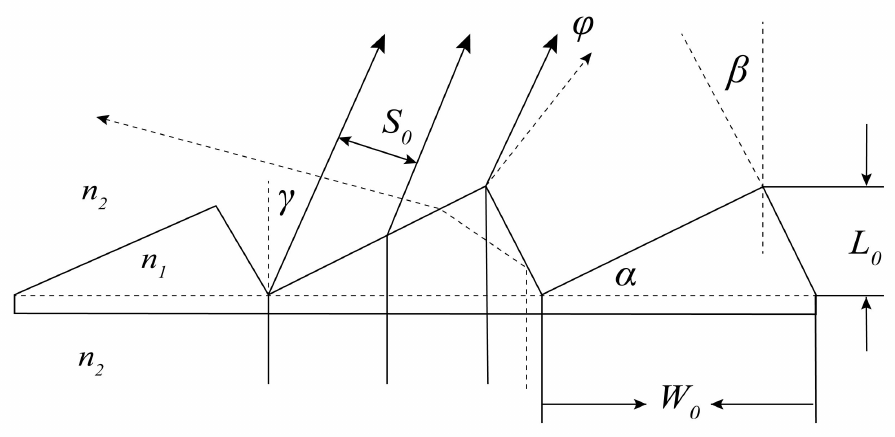
Figure 3. Schematic diagram of a microprism with three prism